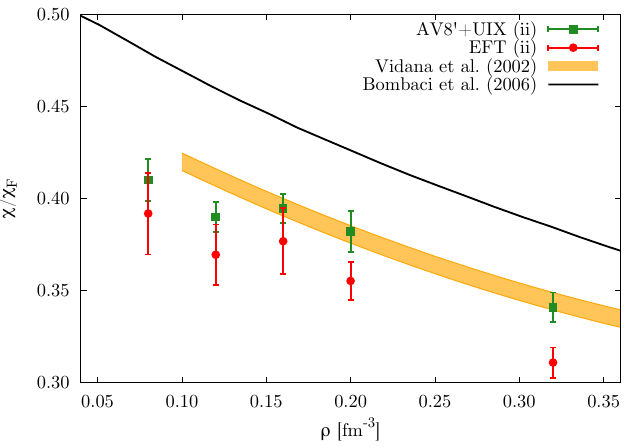
Figure 8. Spin susceptibility ratio χ / χ F in PNM as a function of the density. Green squares (red circles) are results for the AV8 (cid:48) +UIX (local chiral EFT) potential from approach (ii). The black line shows the BHF results of Ref. [3] for the two-body interaction AV18. The orange band reports the BHF results of Ref. [2] for the two-body NSC97e interaction in a parametrization for high-spin